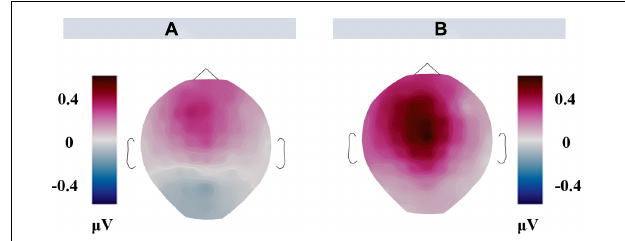
FIGURE 5 | (A) Scalp distribution of the congruent-minus-incongruent difference waves in 500–800 ms. (B) Scalp distribution of the congruent-minus-incongruent difference waves in 500–800 ms derived from the values of fifth picture minus the first picture. That is, values in congruent trials (values of the fifth picture minus the first picture in congruent condition) minus values in incongruent trials (values of the fifth picture minus the first picture in incongruent